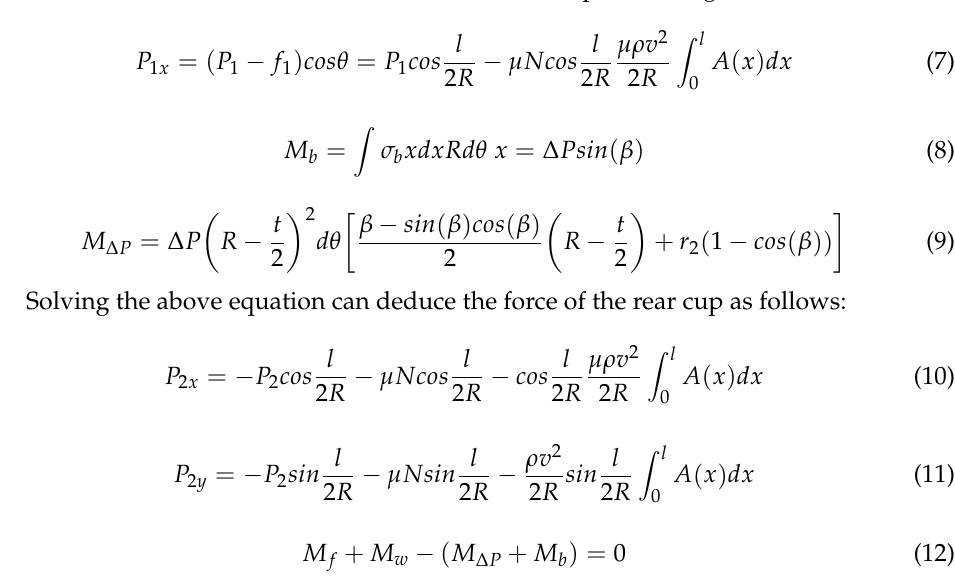
Figure 4. Comparison of the fi nite element and dynamic models. During the movement of the pipeline robot, the leather bowls are deformed under pressure. To increase the scienti fi c validity of the simulations and experiments, the leather bowls were made of polyurethane. Therefore, stress veri fi cation of the polyurethane leather bowls was needed to meet the experimental requirements. The leather bowl model parameters and physical parameters are shown in Figure 5. In the fi gure, 𝑅 (cid:3003) is the radius of the leather bowl, 𝑅 (cid:3021) is the radius of the rigid body through-hole, 𝑟 (cid:3003) is the radius of the rigid body and 𝐿 (cid:3003) is the total length of the rigid body. The physical parameters of the leather bowl are shown in Table 1. Figure 5. Leather bowl model parameters. Table 1. Physical parameters of sealing cup. Physical Quantities